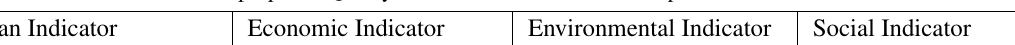
Table 6. Research proposed Quality of life indicators — From the point of view of the